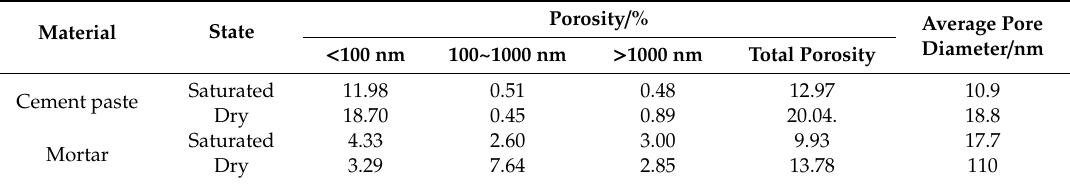
Table 6. MIP results (water / cement ratio = 0.41).